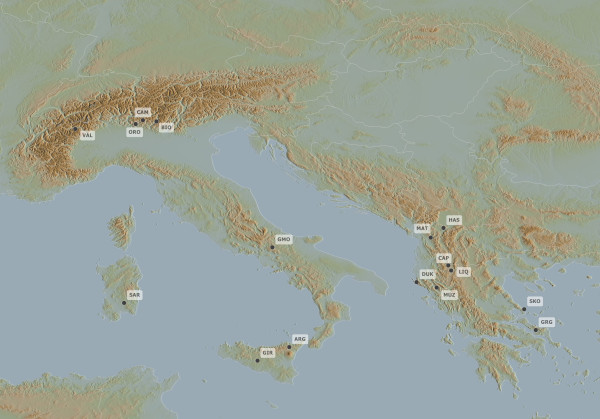
Rearing area of each analysed breed.